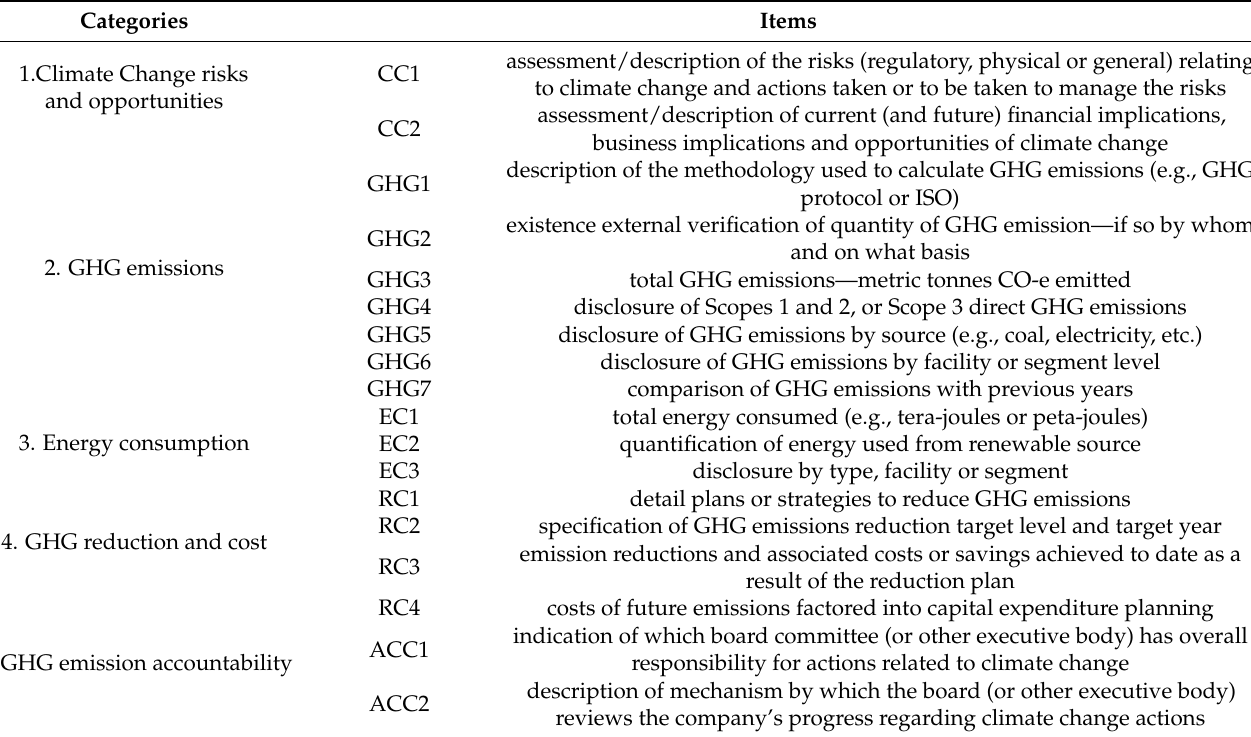
Table 2. Contents Analysis Index for Scoring Sustainable